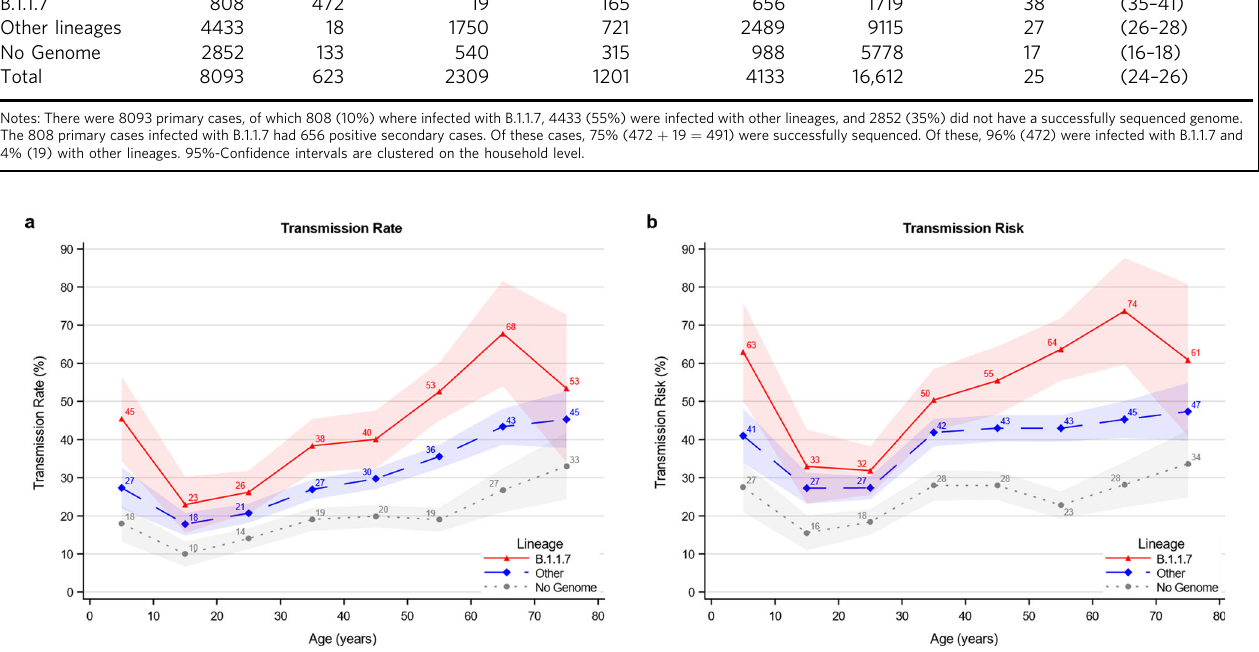
Fig. 1 Age structured transmissibility strati fi ed by lineage of the primary case. a The transmission rate describes the proportion of potential secondary cases within the household that were infected. b The transmission risk describes the proportion of infected primary cases that infected at least one secondary case. Figure S7 provides the same graphs for fi ve-year age groups. The markers show the estimates of the mean. The shaded areas show the 95% con fi dence bands of the estimates clustered on the household